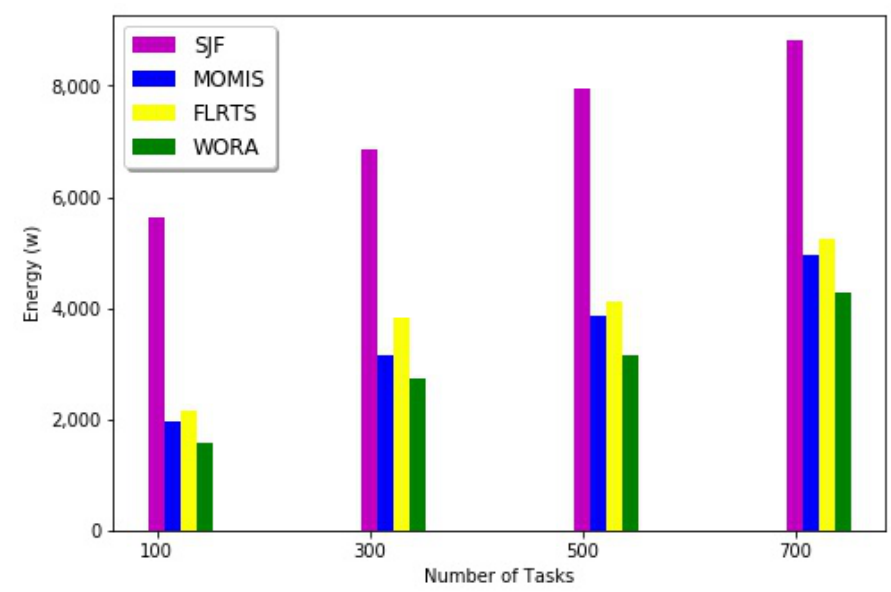
Figure 12. Computation of energy consumption of tasks with 15 fog